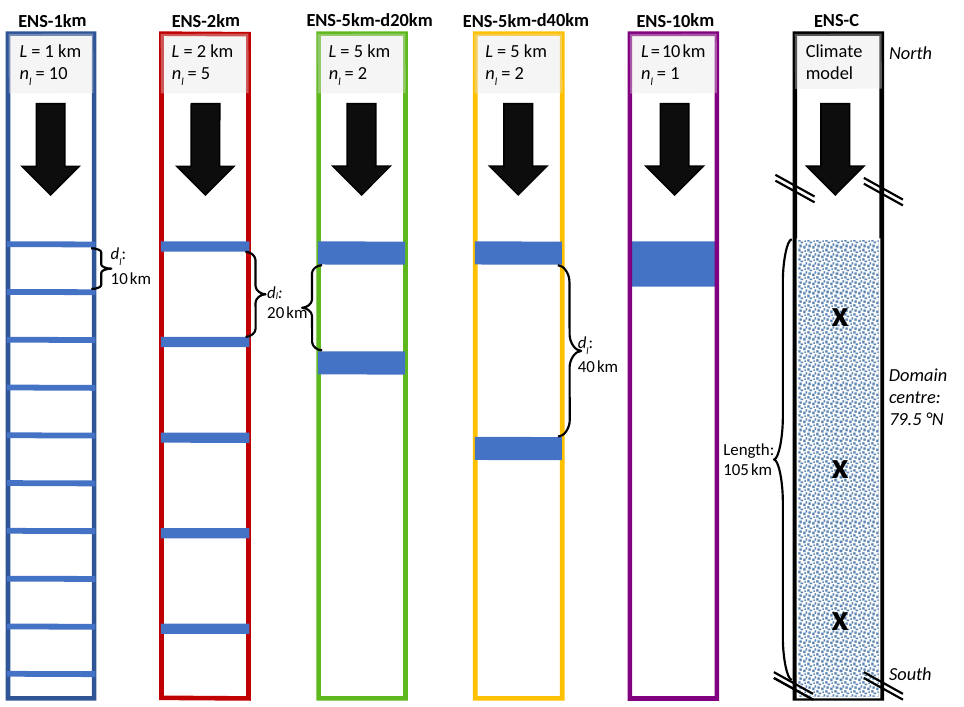
Figure 2. Sketch of the model domains representing the six different cases ENS-1km, ENS-2km, ENS-5km-d20km, ENS-5km-d40km, ENS-10km, and ENS-C. The domains consist of 100% sea ice (white areas), leads (blue rectangles), or of a fractional sea ice concentration of approximately 91% (mosaic area, only in case ENS-C). The parameters belonging to the first five cases are the lead width L , the number of leads n l , and the distance between two consecutive leads d l . Related simulations of these cases were performed with a horizontal grid spacing of 200m in lead-perpendicular direction. Case ENS-C represents a few grid cells of a regional climate model, where the crosses denote the grid point positions in a distance of 35km to each other in flow direction. The length of the inflow region over closed sea ice is 50km for the lead-resolving cases or 385km for case ENS-C. Averaged over a region of 105km length starting from the downwind edges of the inflow regions, in all six domains, the sea ice concentration amounted to 91%. The different cases are distinguished by color, which is also used to distinguish the corresponding simulation results in the subsequent figures of this